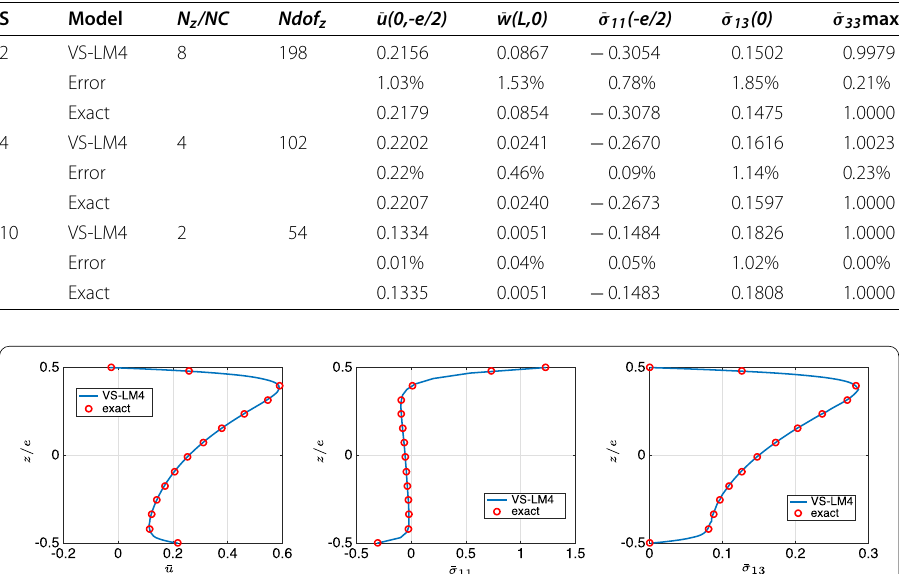
Fig. 4 Distribution of ¯ u (left), ¯ σ 11 (middle) and ¯ σ 13 (right) along the thickness—S=2–1 layer— φ = π/ 8